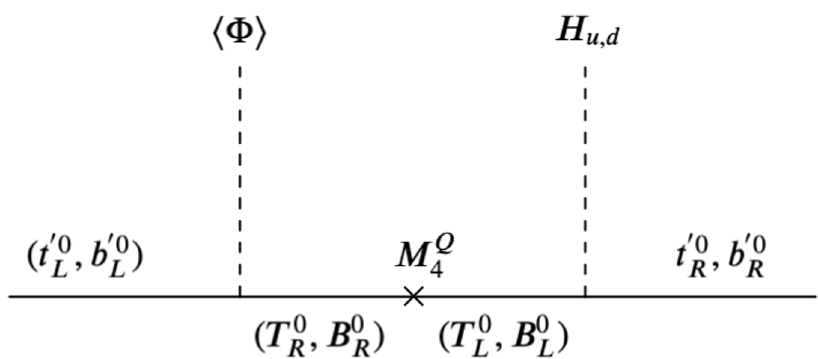
Figure 1. The origin of the third family ( t, b ) quark Yukawa couplings in this model.